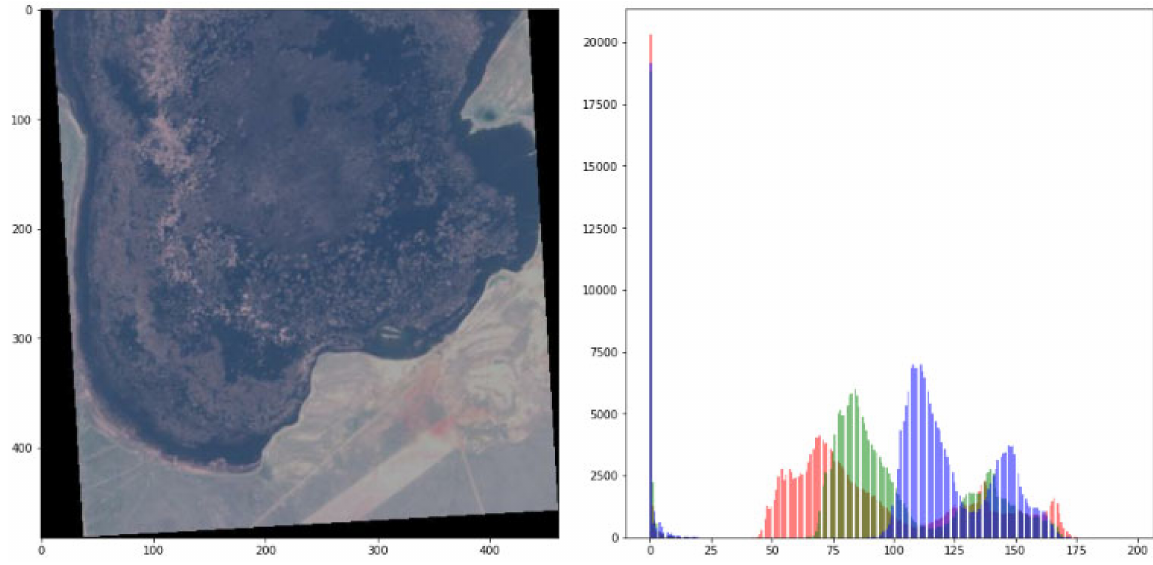
Figure 6. Exploratory data